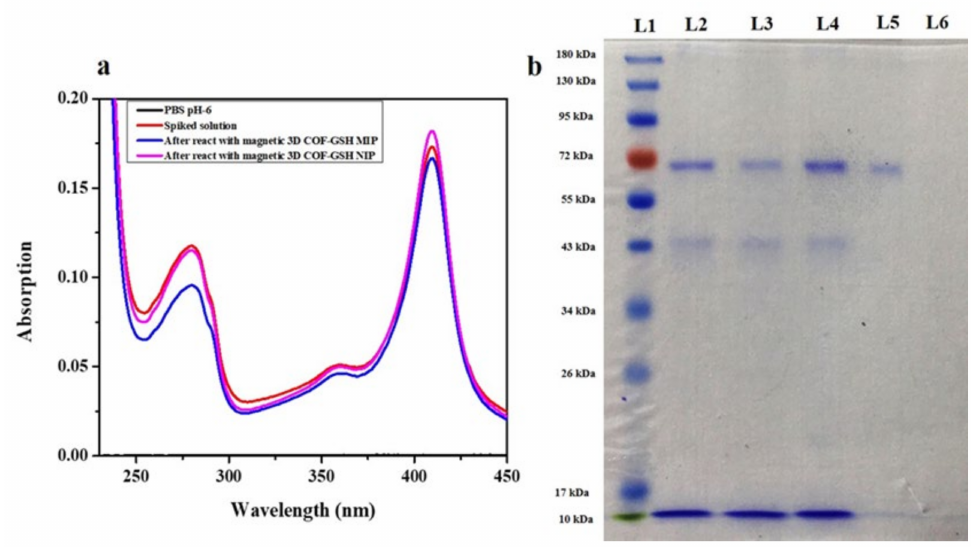
Figure 6. ( a ) UV–Vis analysis and ( b ) SDS–PAGE analysis for compatibility of magnetic 3D COF– GSH MIPs/NIPs. L1: Marker, L2: PBS with spiked proteins, L3; and L4: supernatant solutions after adsorption with magnetic 3D COF-GSH MIPs and NIPs respectively, L5; and L6: Eluted solutions from magnetic 3D COF-GSH MIPs and NIPs in 0.5% SDS and 0.1% HOAc (1:1)